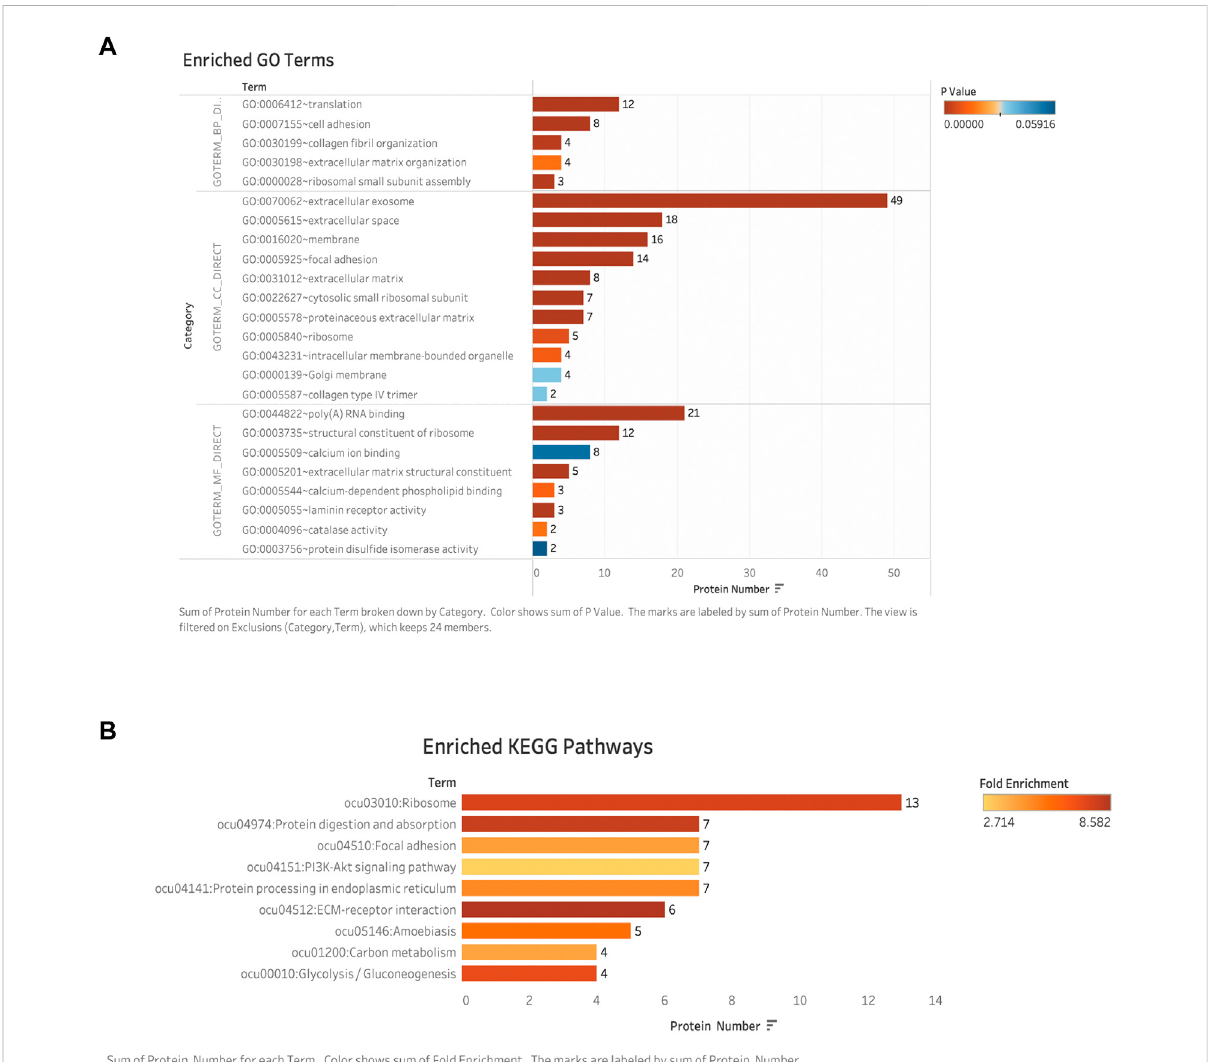
FIGURE 7 Bioinformatic analysis: (A) GO enriched analyses of differentially expressed proteins (DAPs) in late-stage neointima. The y -axis was the protein functional classi fi cation of GO: biological process (BP), cellular components (CC), and molecular function (MF). The x -axis was the number of proteins in each classi fi cation. Different colors indicated different P-valves. (B) Enriched pathways according to KEGG functional classi fi cation analyses of DAPs. The y -axis was the signi fi cantly enriched KEGG pathways. The x -axis was the number of DAPs contained in each KEGG pathway. Different colors indicated the different fold enrichment. DAPs: differentially expressed proteins; GO: Gene Ontology; KEGG: Kyoto Encyclopedia of Genes and